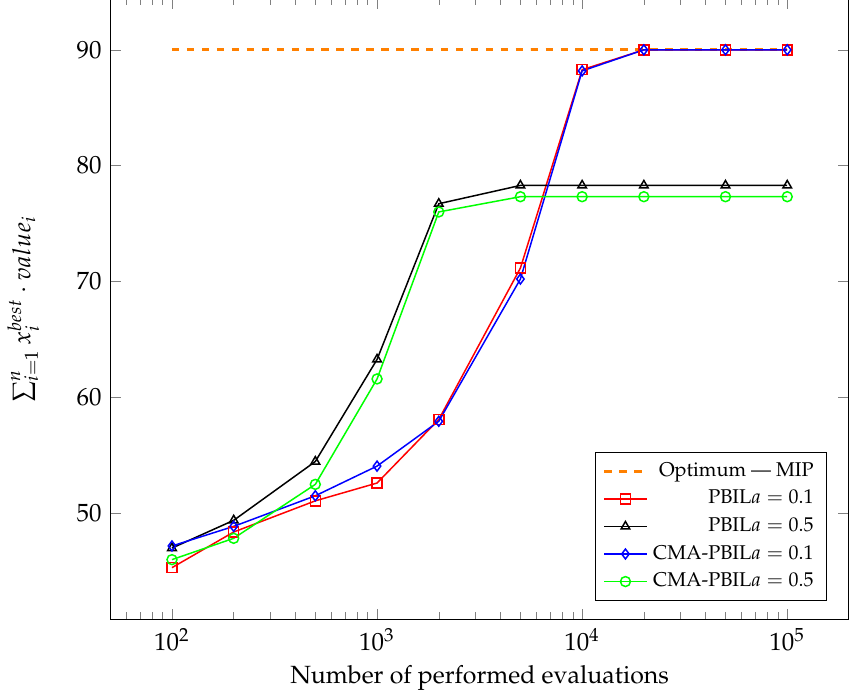
Figure 5. The average of the maximal values of the objective function calculated so far, test case no